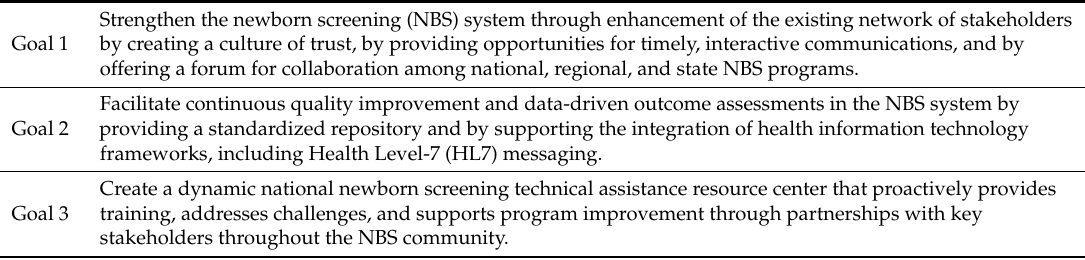
Table 2. NewSTEPs Goals (2014–2018).